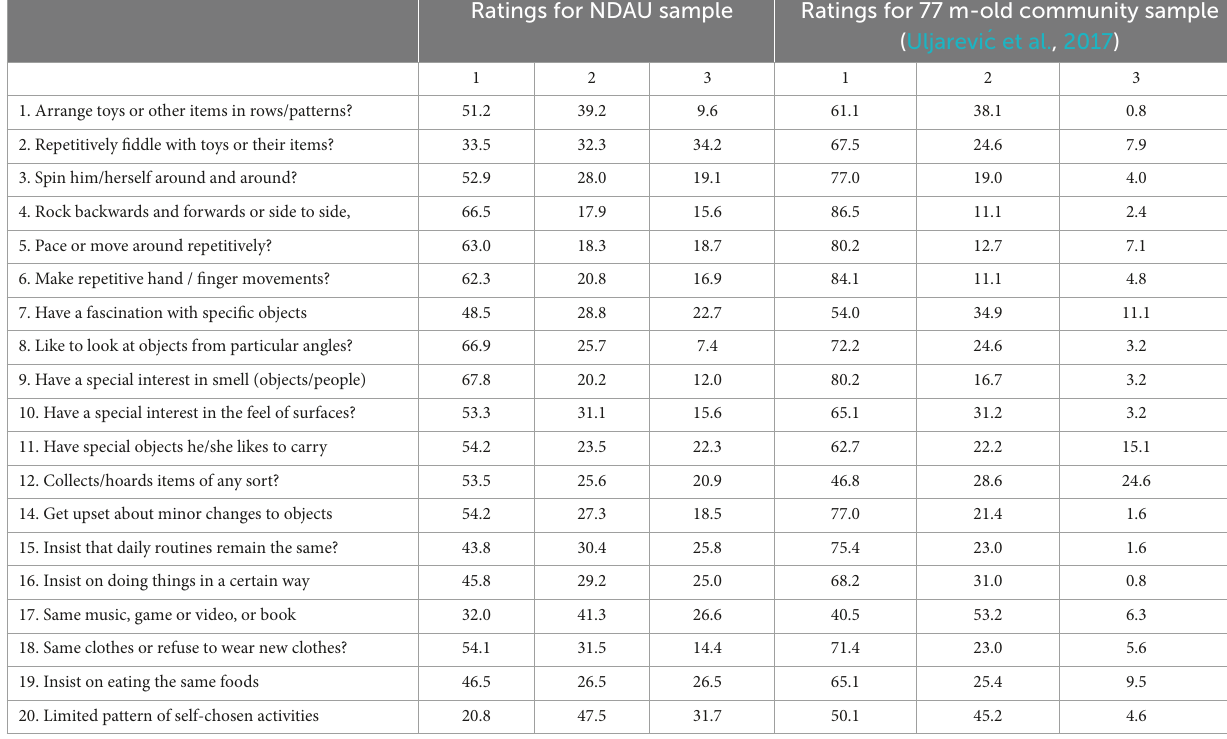
Ratings for NDAU sample Ratings for 77 m-old community sample